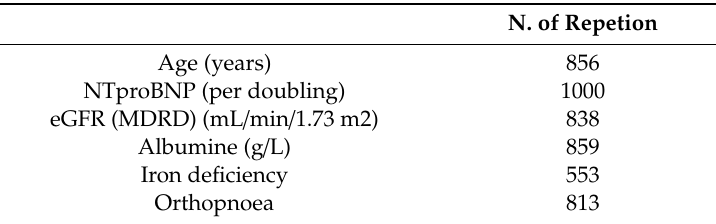
Table A3. Results of the bootstrapping analysis.